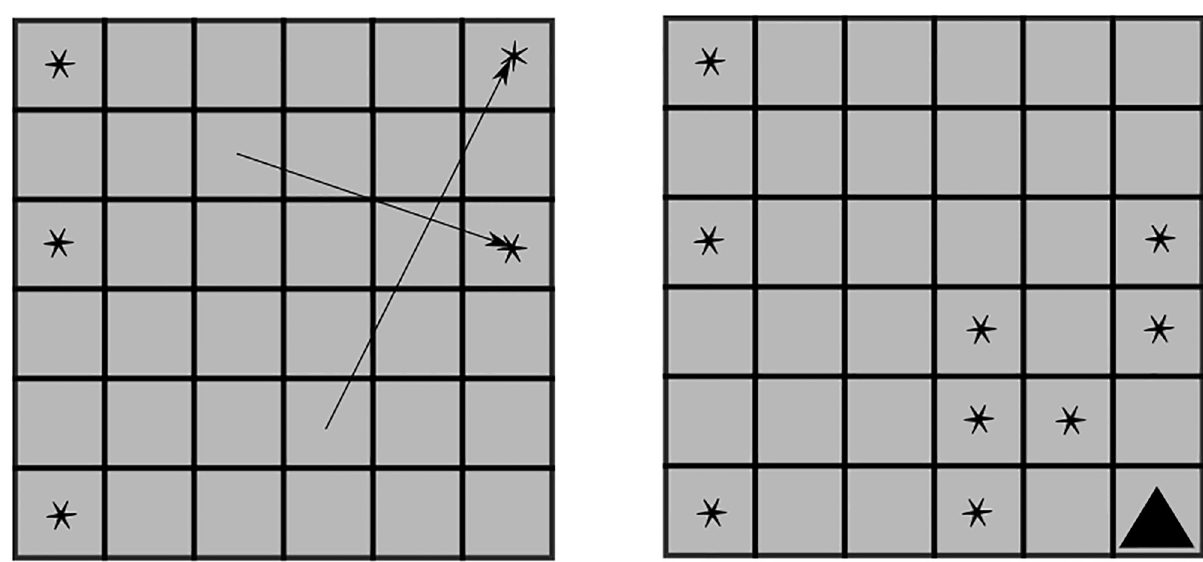
Fig 5. Diffusion and error correlation in SCEG. On the left, the diffusion mechanism is illustrated: locally caused conflict events will experience “outcome diffusion” and relocate to a random simulated location within a predefined radius. On the right, the presence of a military base indicated by the triangle in the lower right corner causes more conflict events in its